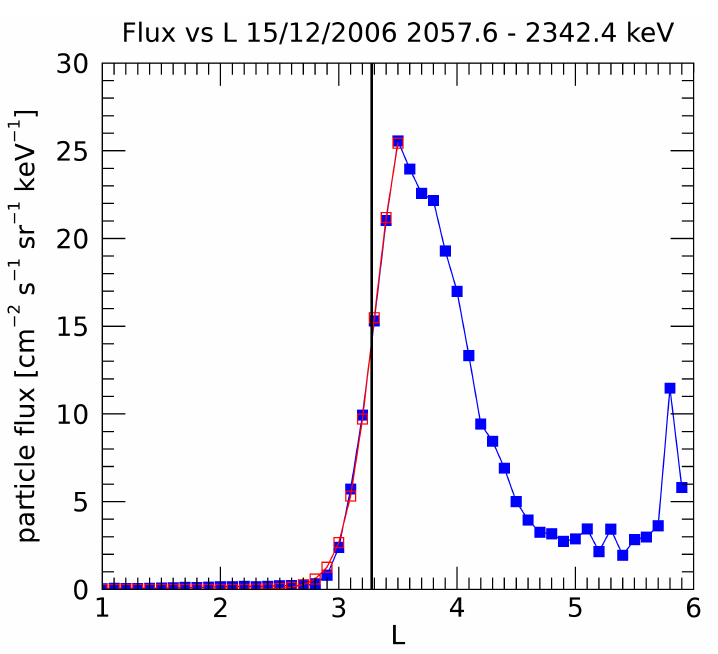
Figure 9. The particle flux measured during the 15 December 2006 storm in the energy range 2057.6–2342.4keV (blue). The left-most flank is fitted with a hyperbolic tangent (red). The position of the L barrier is defined as the point, where the flank reaches half of its height. This position is marked by the vertical black